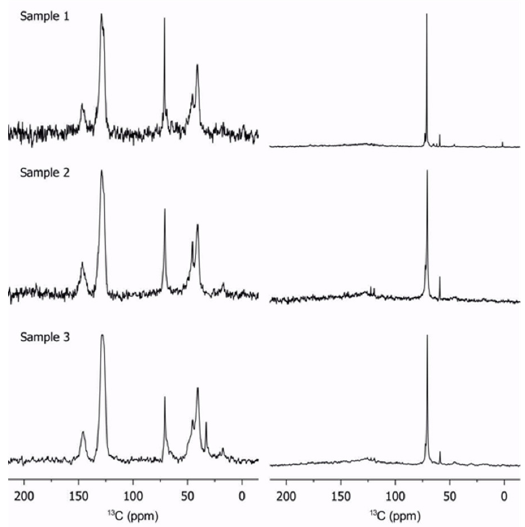
Figure 1. Cross ‐ polarization solid ‐ state 13 C NMR (left column) and direct pulse solid ‐ state 13 C NMR excitation (right column) of samples 1 to 3 at 298 K. All spectra are normalized by maximum peak intensity; the change in noise level thus reflects the amount of rigid segments in the polymer.